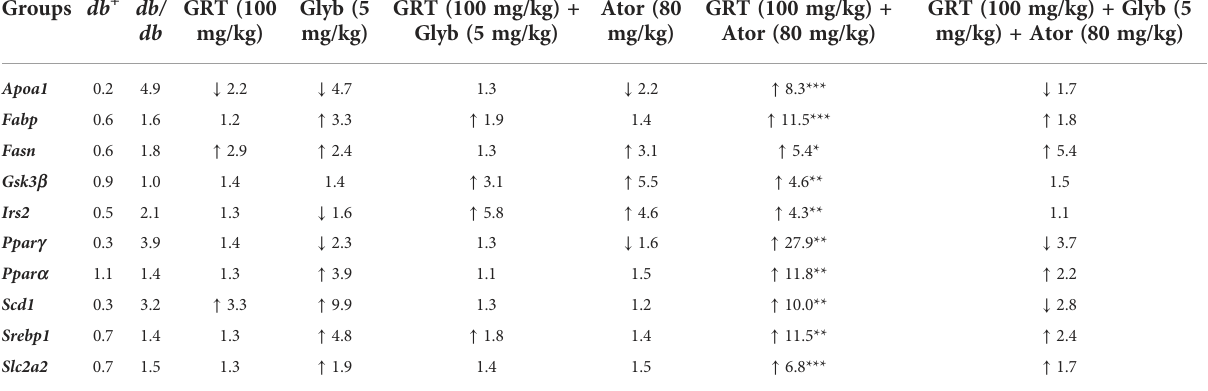
TABLE 2 Summary of gene expression of the liver of db/db mice. Groups db +